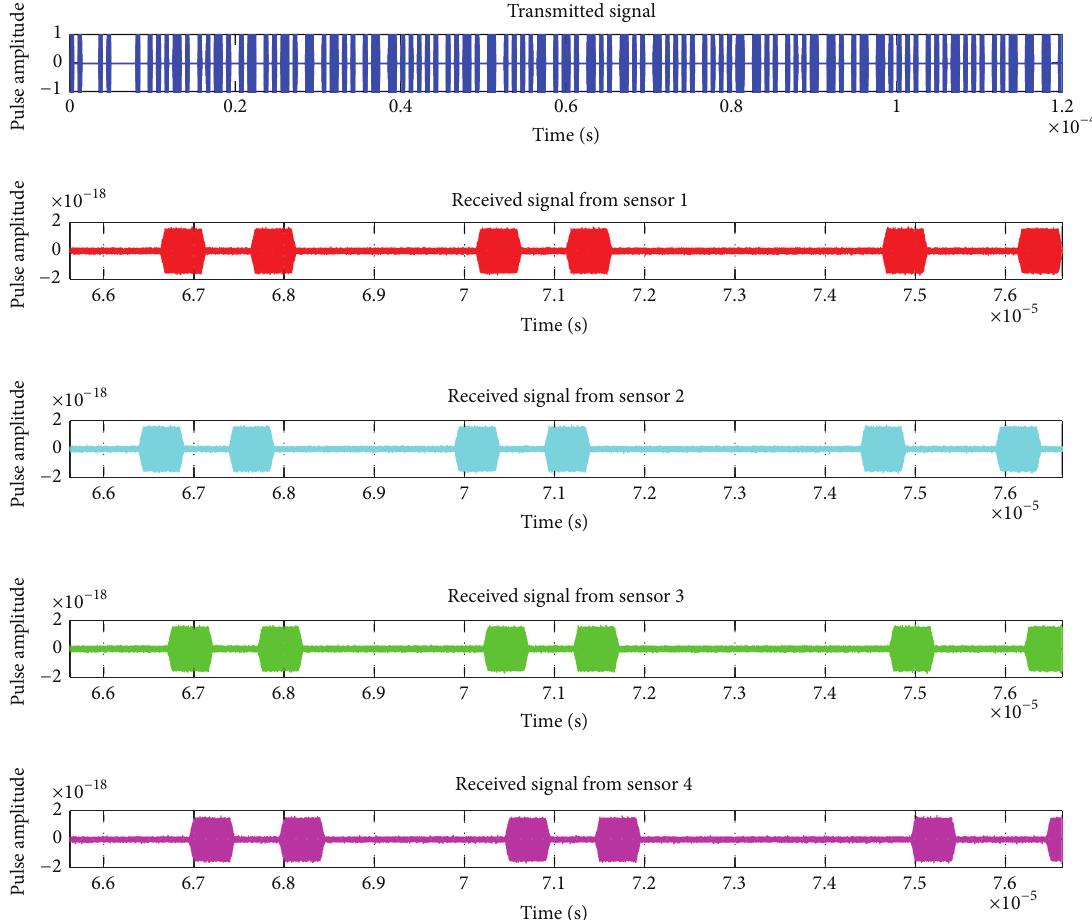
Figure 8: Transmitted ADS-B radar signal and received signals from four